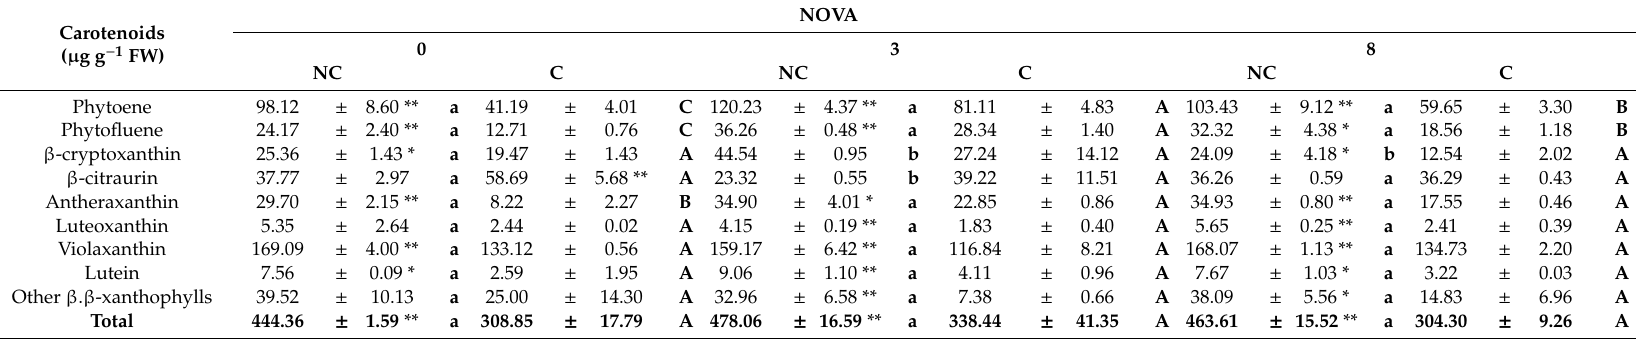
Table 2. Individual and total carotenoids ( µ g g − 1 FW) detected in the peel of non-covered (NC) and covered (C) fruit of Nova mandarin at harvest (0) and after 3 and 8 weeks of storage at 2 ◦